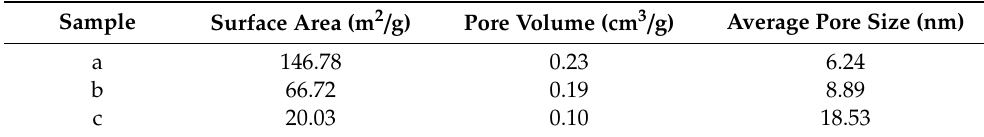
Figure 5. Pore size distributions of as-synthesized ( a,b ) and calcined zirconia ( b ) calcined at 723 K; ( c ): calcined at 923 K. Table 1. The textural properties of as-synthesized (a,b) and calcined zirconia (b) calcined at 723 K; (c): calcined at 923